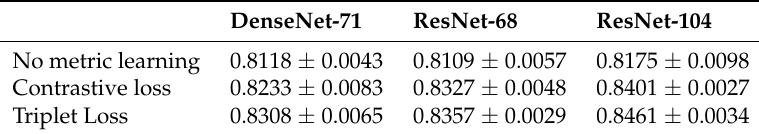
Table 3. Dice coefficient values: average ± standard